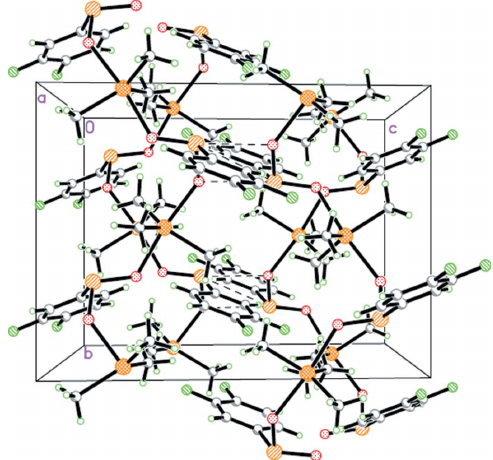
Figure 3 A perspective view along [100], showing the crystal packing of the title